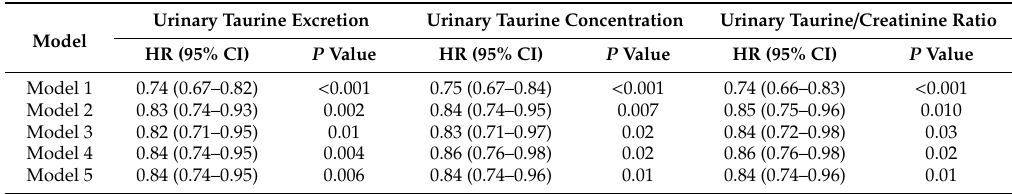
Table 2. Association of urinary taurine excretion, urinary taurine concentration and urinary taurine creatinine ratio with death-censored graft